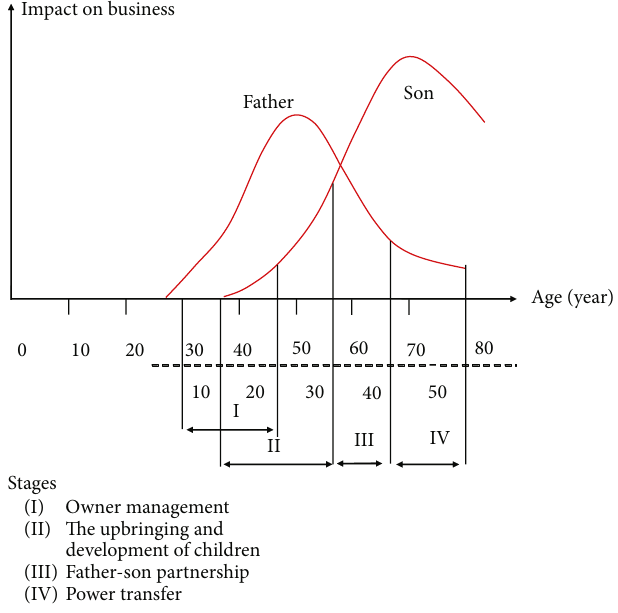
Figure 1: Four-stage inheritance